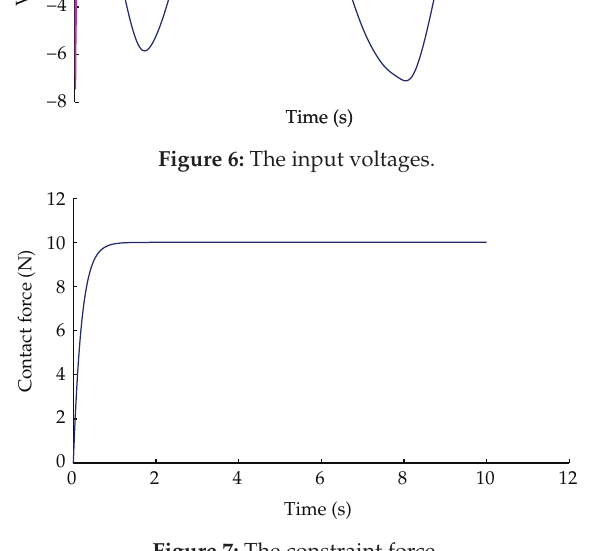
Figure 7: The constraint force.